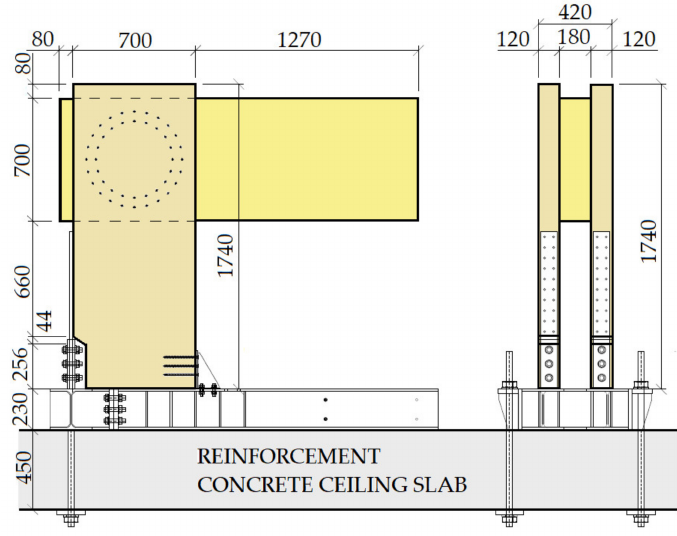
Figure 1. Design test system.